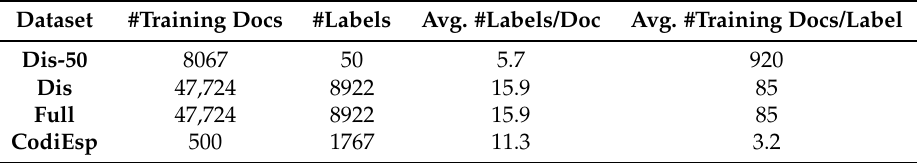
Table 1. Dataset specifics